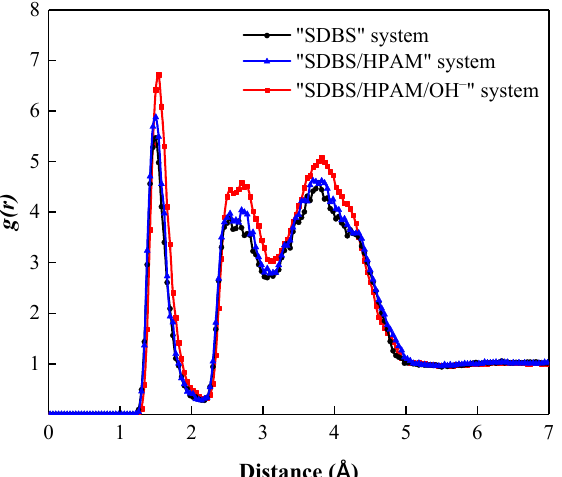
Figure 2. Radial distribution function of water molecules around SDBS head group in different foam systems.